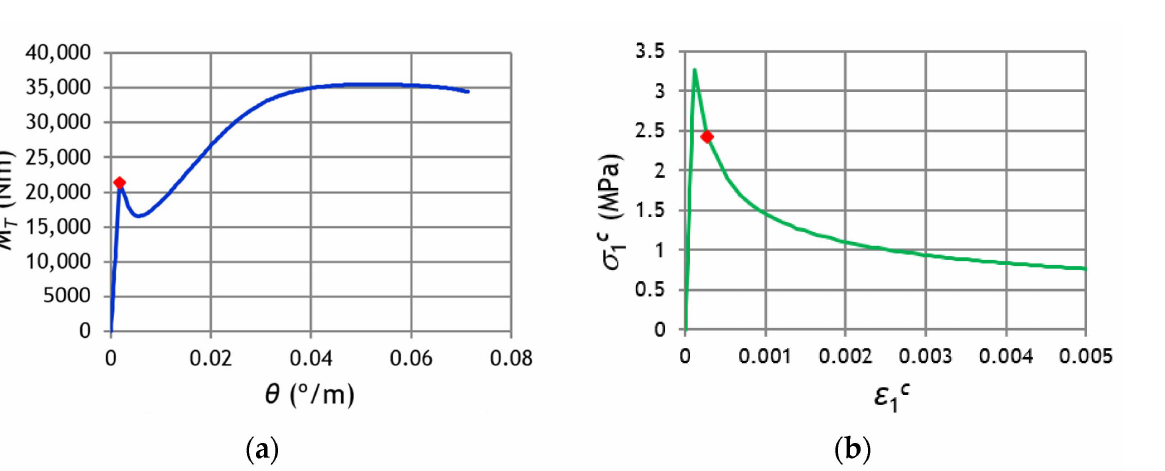
Figure 5. Comparison between the smeared constitutive laws. Figure 6. Location of the effective cracking